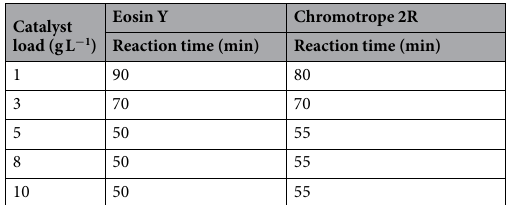
Table 1. Effect of catalyst load on catalytic decomposition of Eosin Y and Chromotrope